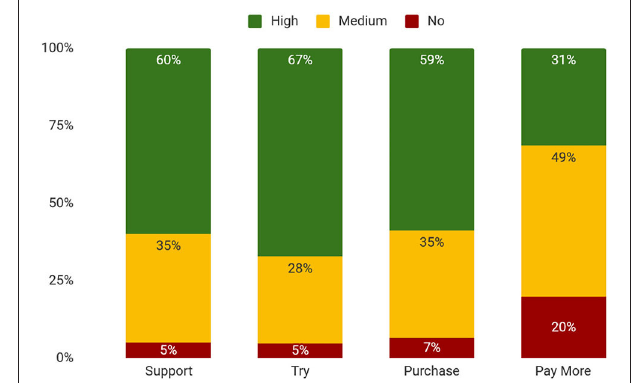
FIGURE 2 | Current familiarity with plant-based meat in the general population and by generations.